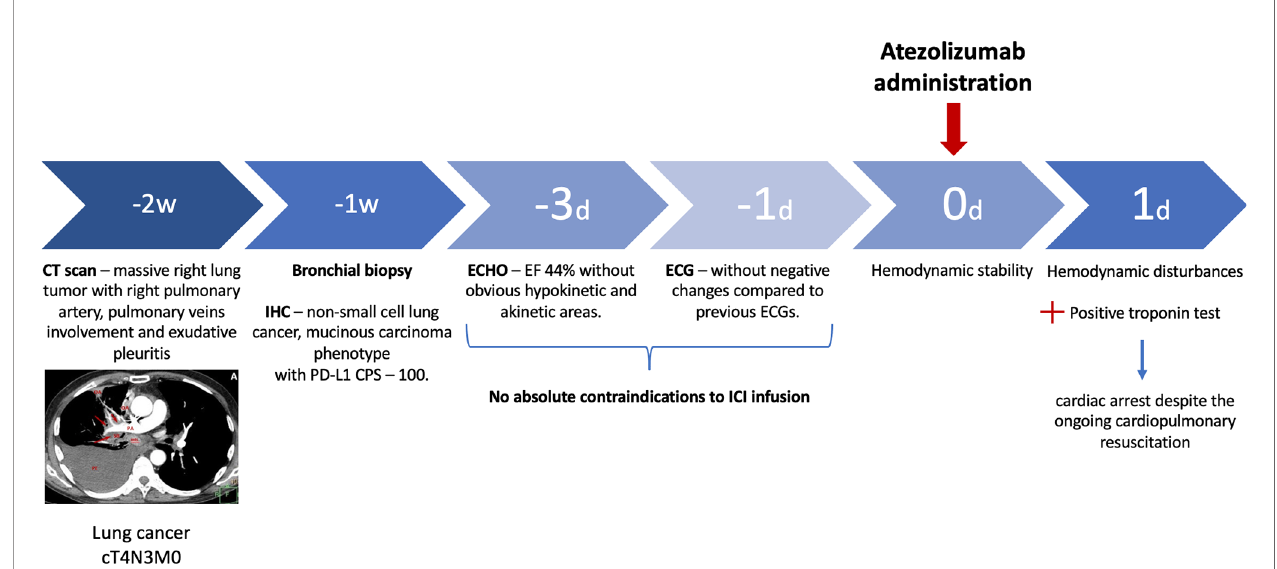
FIGURE 1 | Timeline. D, day; W, week; IHC, immunohistochemistry; CPS, combined positive score; ECHO, echocardiogram; ECG, electrocardiogram; ICI, immune checkpoint